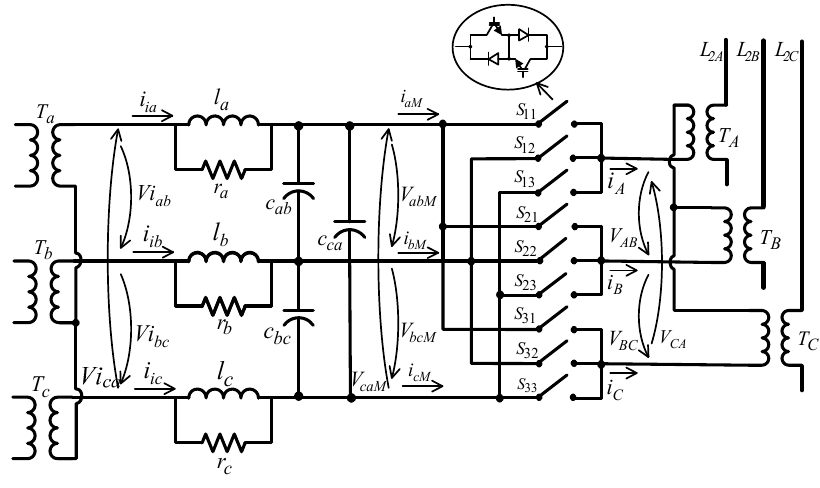
Figure 2. A detailed diagram with DMC-UPFC.